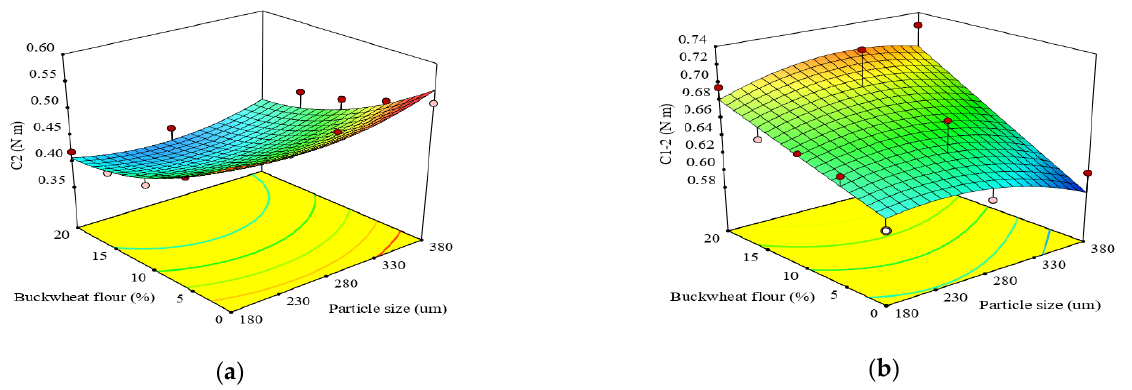
Figure 2. 3D response surface plots showing interaction between buckwheat flour particle size and addition level on ( a ) C2 torque (C2) and ( b ) difference between torques C1 and C2 (C1-2) during protein weakening.